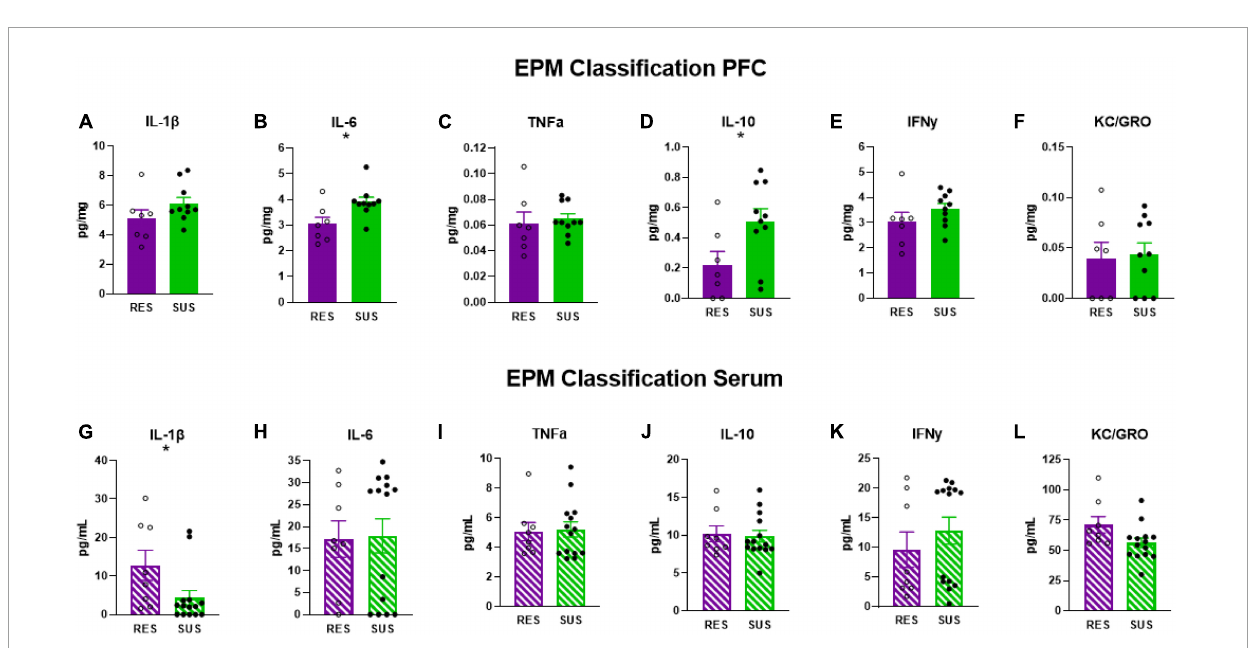
FIGURE4 IL-1 β , IL-6, TNF α , IL-10, IFN γ , and KC/GRO levels in PFC and serum based on EPM classification (PFC: Res n = 7, Sus n = 10, Serum: Res n = 8, Sus n = 14). Protein levels of IL-1 β , IL-6, and TNF α are in pg/mg for PFC and in pg/mL for serum. * p < 0.05.